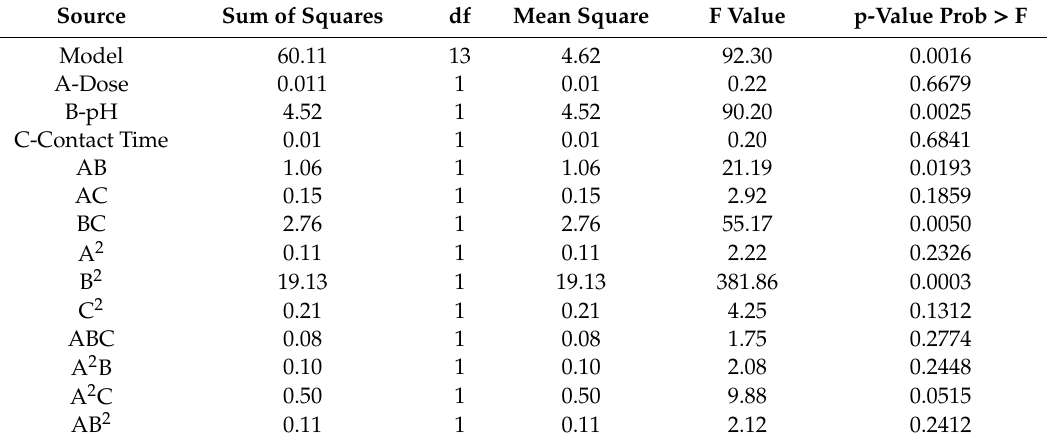
Table 8. ANOVA of optimization Al 3 + uptake capacity (mg · g − 1 ) on bio-powder activated carbon